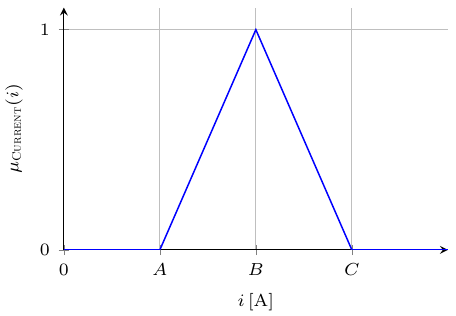
Figure 5. Each membership function is described by a vector v = [ A , B , C ] T